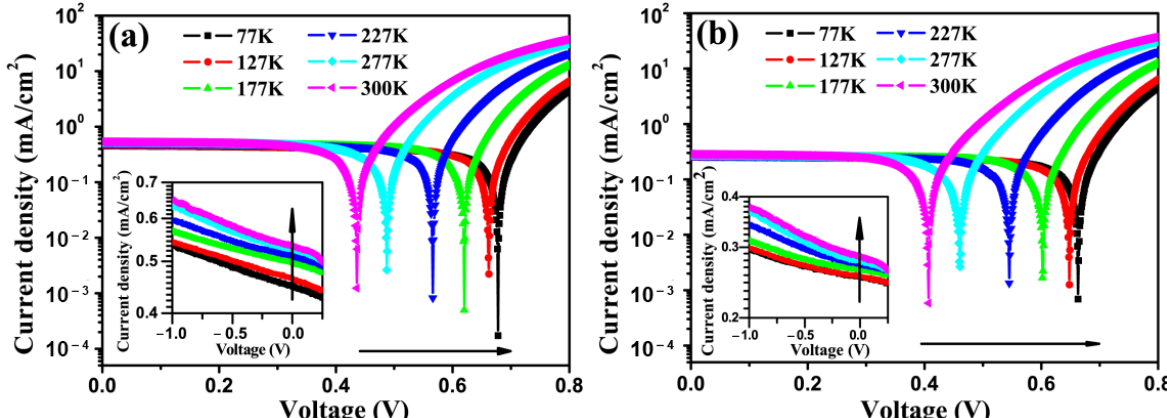
Figure 2. J-V characteristics of OSCs at various temperatures, under illumination of tungsten lamp light ( a ) without and ( b ) with a 600 nm long-wave pass optical filter. The insets show details of J-V curves in the range of − 1~0.25 V. Device structure is: ITO/CuPc (20 nm)/C60 (55 nm)/Alq3 (6 nm)/Al (100 nm).